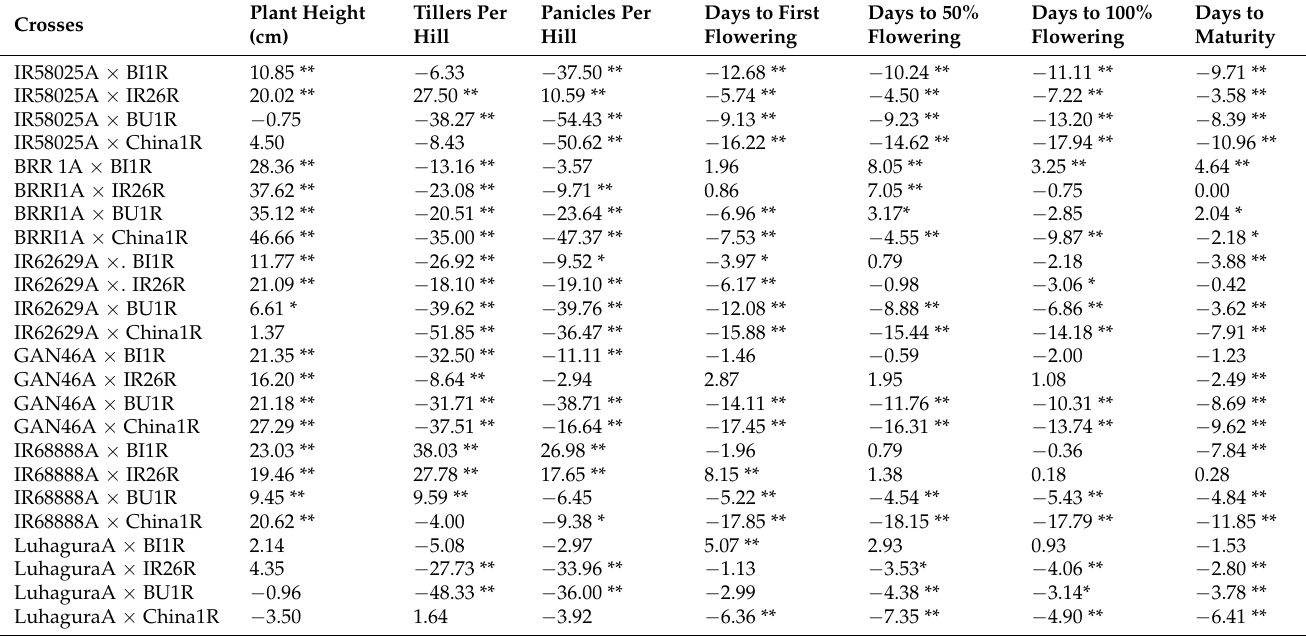
Table 5. Estimates of mid-parent heterosis of 24 crosses for yield and its contributing